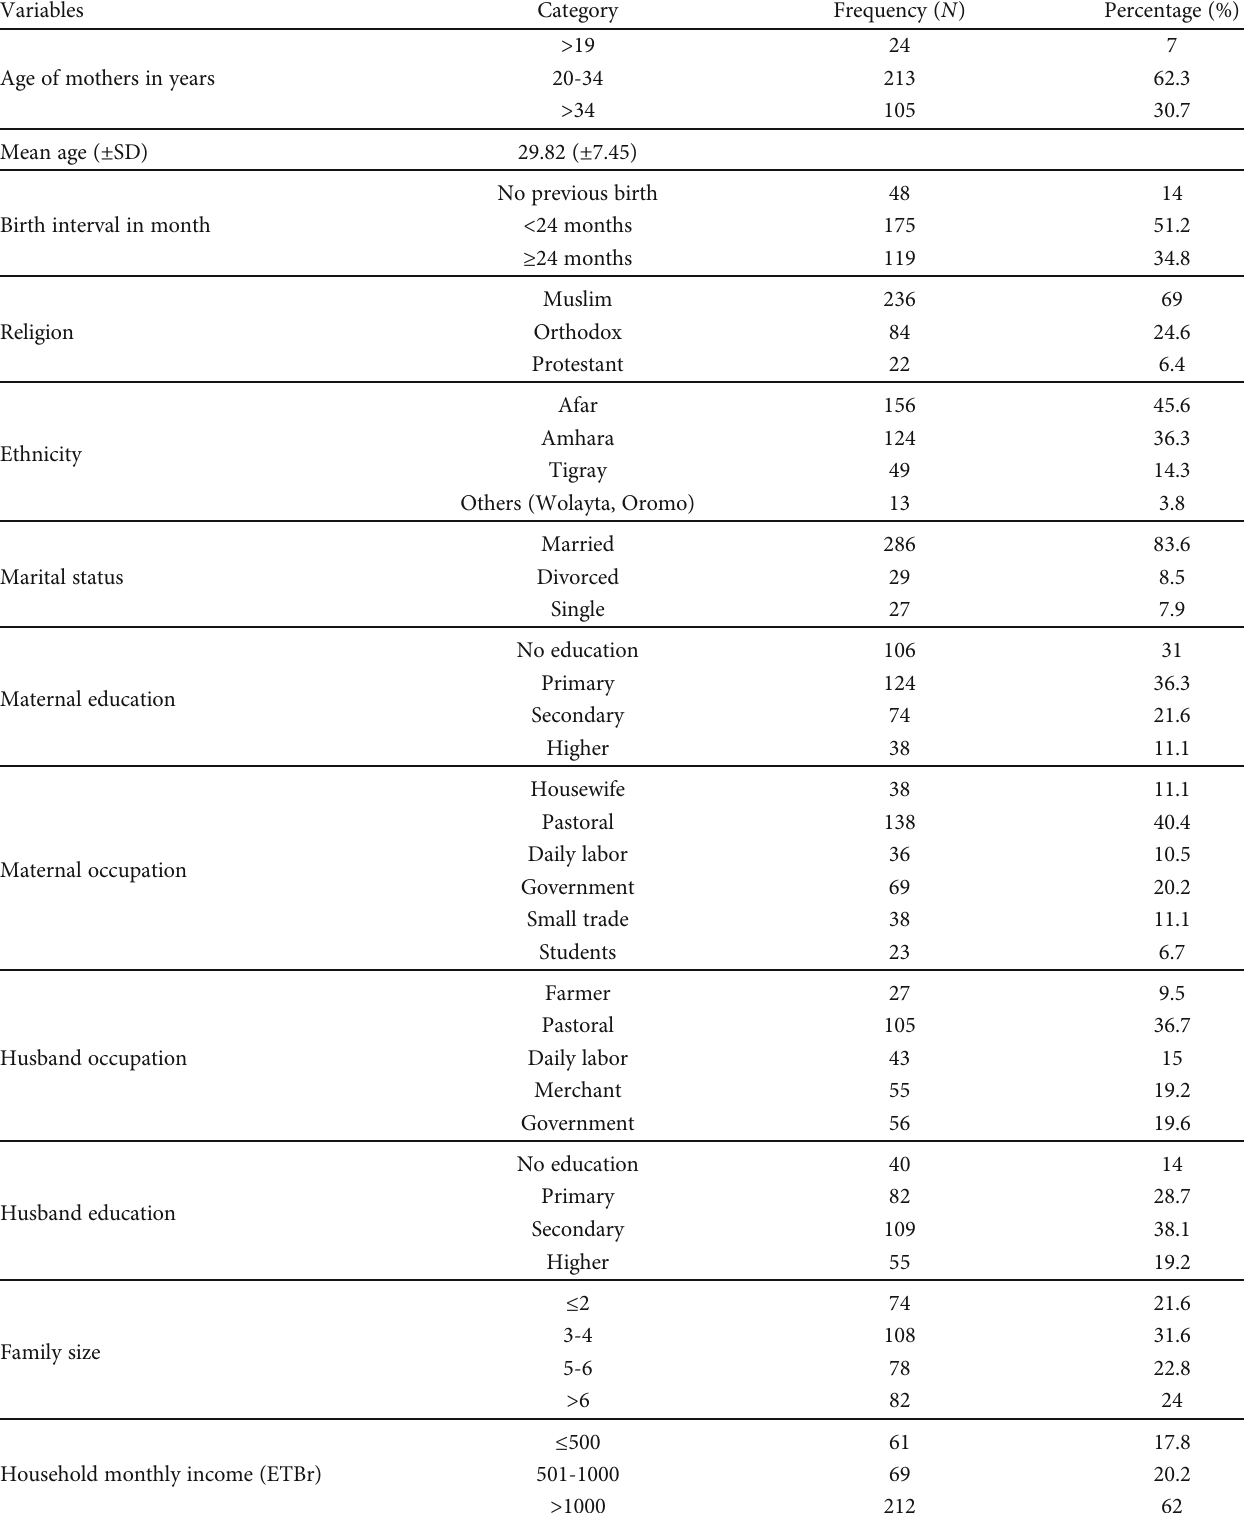
Table 1: Sociodemographic characteristics of the study participants in Dubti town, pastoral community, Afar region, Northeast